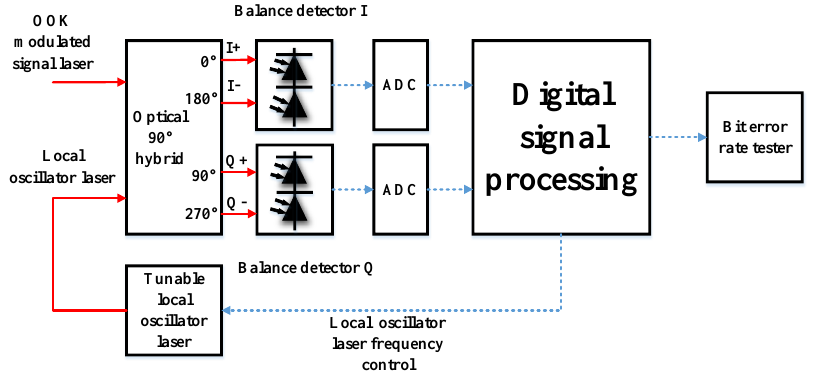
Figure 3. Experimental structure of coherent OOK receiver. For the coherent reception of OOK, the best LO power was determined to be 12.8 mW by calculating the SNR of the beat frequency signals using the cross-correlation method. The OOK format signal light and the LO light enter the optical 90 ◦ hybrid, and the hybrid outputs four channels of light. Two lights from the in-phase (I) branch enter one BD and two lights from the quadrature (Q) branch enter the other BD. The BD was the same as the BD used for non-coherent reception. The voltage signals generated by the four output lights are presented as